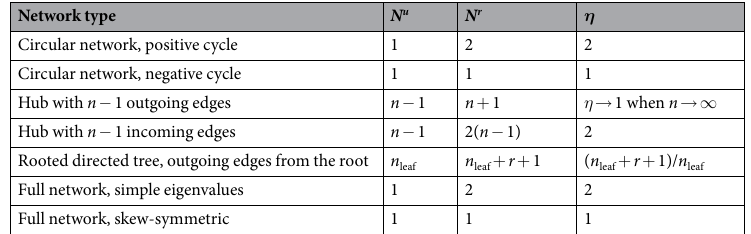
Table 2. The number of unrestricted or unilateral control inputs required for controllability of some specific network structures. For the RDT, the number of leaves coincides with the dimension of the null space, i.e. n leaf = μ 0 , and r is the number of nodes with outdegree ≥